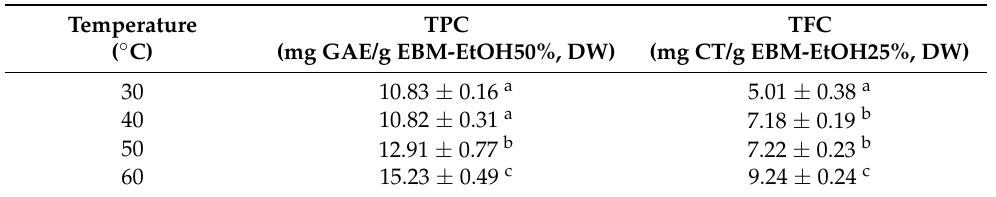
Table 3. Effect of the temperature in the extraction of total polyphenol content (TPC) and total flavonoids content (TFC) of EBM-EtOH50% and EBM-EtOH25%.